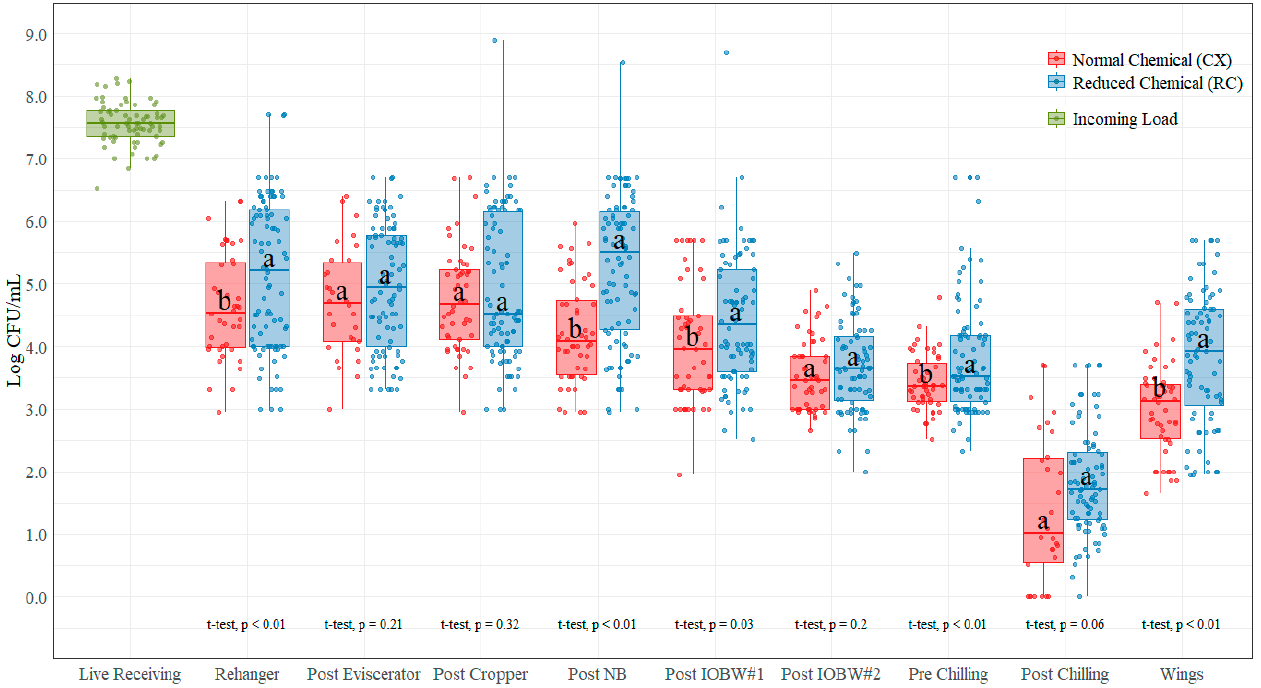
Figure 2. Aerobic plate counts (log CFU/mL) on each of the ten locations during the evisceration process under normal process interventions (CX) and lo- chemical process interventions (RC) on chicken rinses. In each boxplot, the horizontal line crossing the box represents the median, the top and bottom lines of the box represent the lower (0.25) and upper (0.75) quartiles, the vertical top lines represent 1.5 times the interquartile range, and the vertical bottom line represents 1.5 times the lower interquartile range. The dots represent the actual data points. a,b For each location, boxes with different letters are significantly different between treatments according to t -test analysis at p -value < 0.05. Table 2. Enterobacteriaceae counts (log CFU/mL) on each of the ten locations during the evisceration process under normal process interventions (CX) and low-chemical process interventions (RC) on chicken